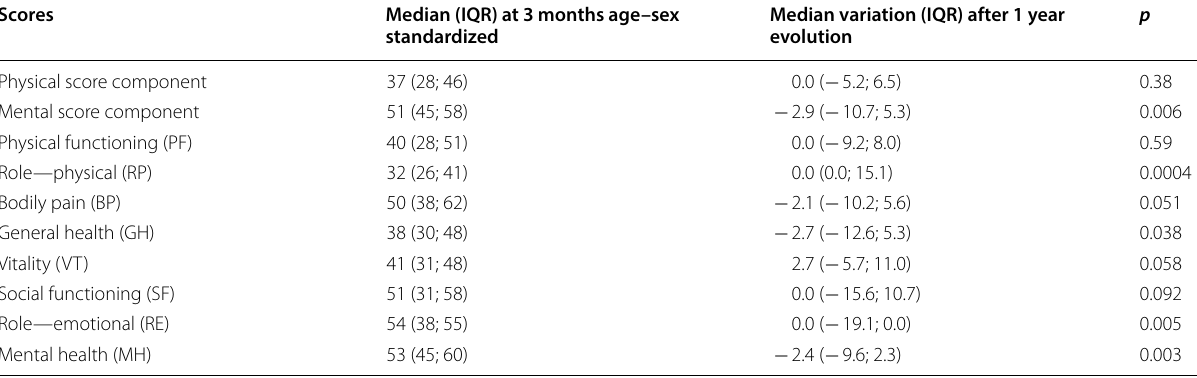
Table 2 SF-36 score evolution from 3 months to 1 year after ICU discharge Scores Median (IQR) at 3 months age–sex